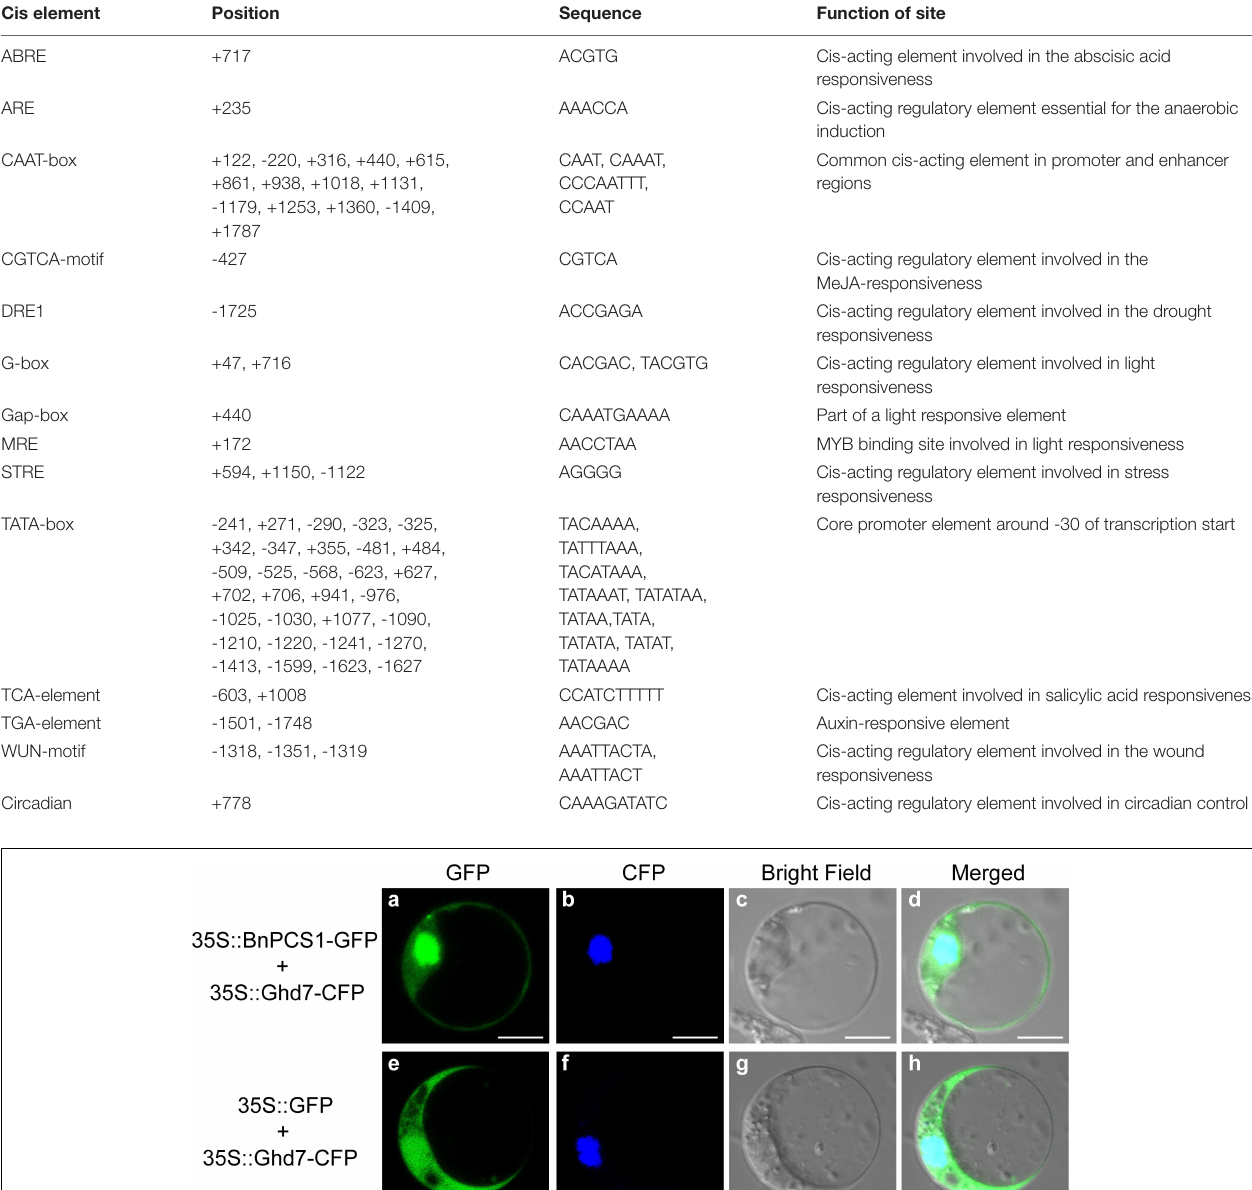
TABLE 1 | Putative cis-acting regulatory elements identified in the promoter region sequence of BnPCS1 using the PlantCARE database.